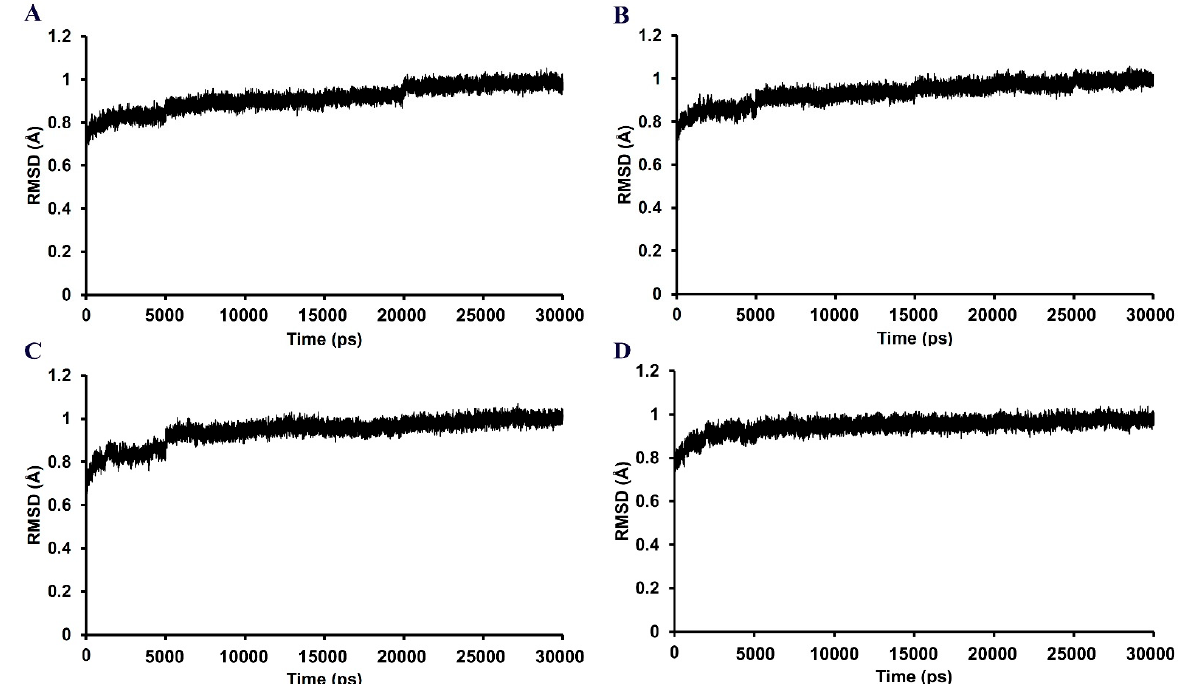
Figure 5. RMSD plots all over the 30,000 ps simulation of the GABA A receptor–ligand coordinates from the ( A ) methyl eugenol, ( B ) 1,8-cineole, ( C ) 4-allylphenyl acetate, and ( D ) diazepam models.